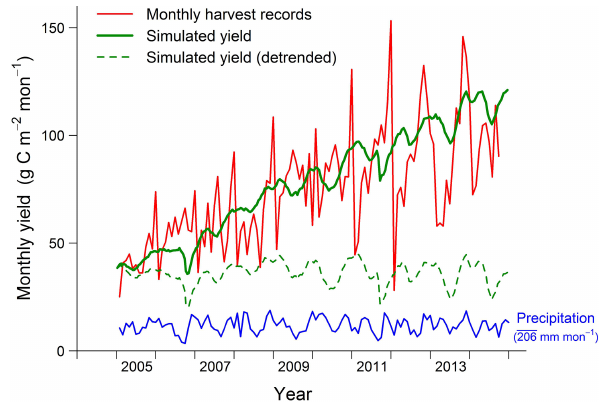
Figure 7. Comparison of simulated and observed monthly yield at PTPN-VI. The modeled yield outputs are per harvest event (every 15–20 days depending on the phyllochron), while harvest records are the summary of harvest events per month. The model output is thus rescaled to show the monthly trend of yield that matches the mean of harvest records, given that the cumulative yields are almost the same between simulation and observation as shown in Fig. 6. The detrended curve is to facilitate comparison with the dynamics of monthly mean precipitation.